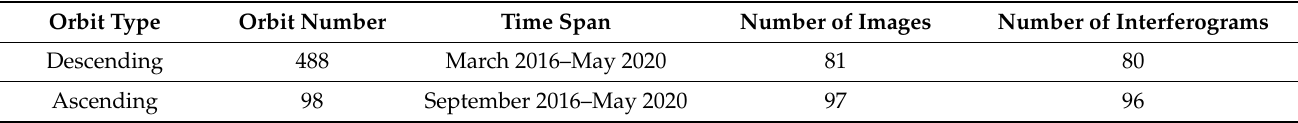
Table 1. Sentinel-1 image